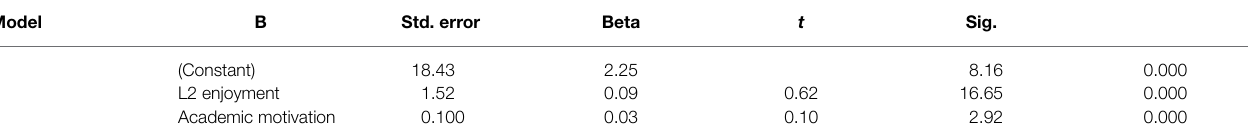
TABLE 5 | The coefficients for academic motivation, L2 enjoyment, and academic engagement.